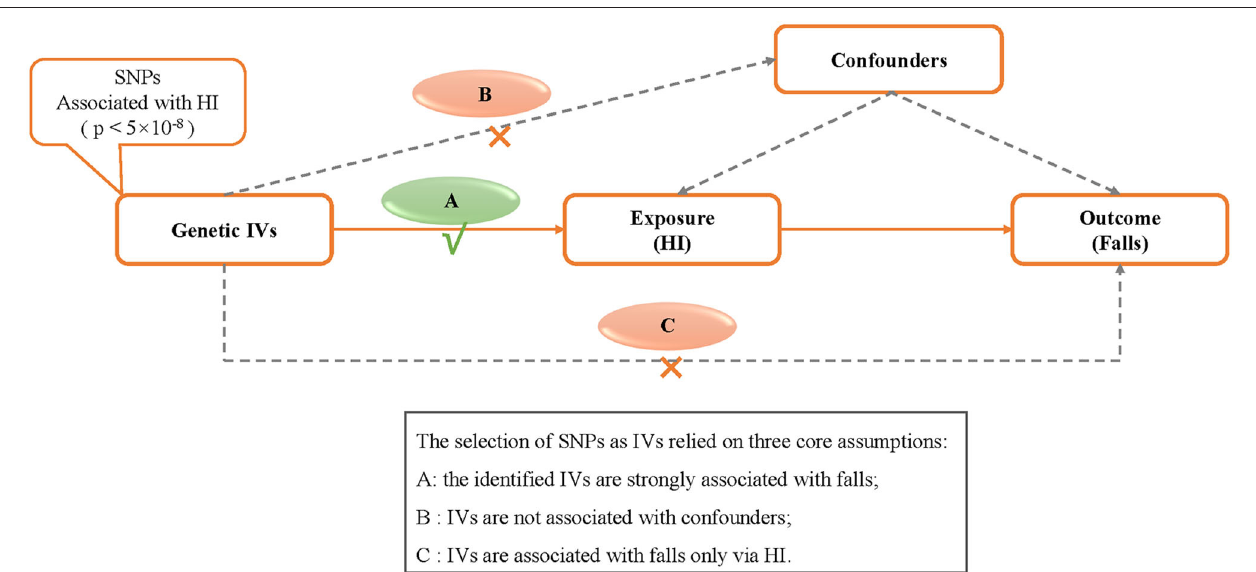
FIGURE 1 | Design of the two-sample Mendelian randomization study. IVs, instrumental variables; HI, hearing impairment; SNP, single nucleotide